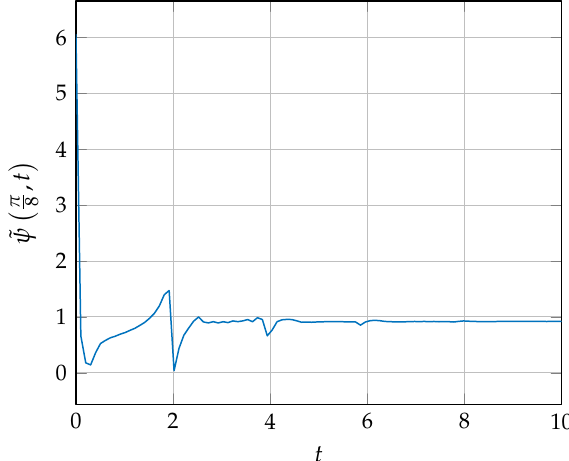
(cid:0) π (cid:1) on the semi-circular scatterer. The parametric , t 8